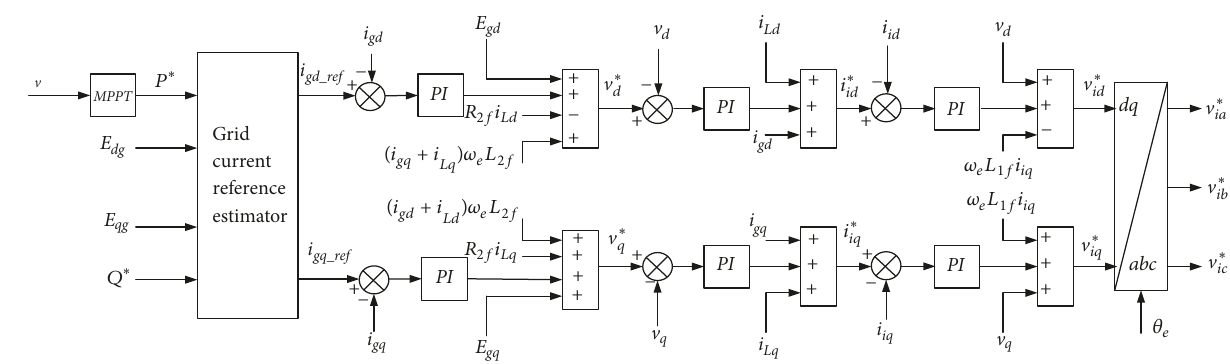
Figure 2: PI regulators used for load voltage control.